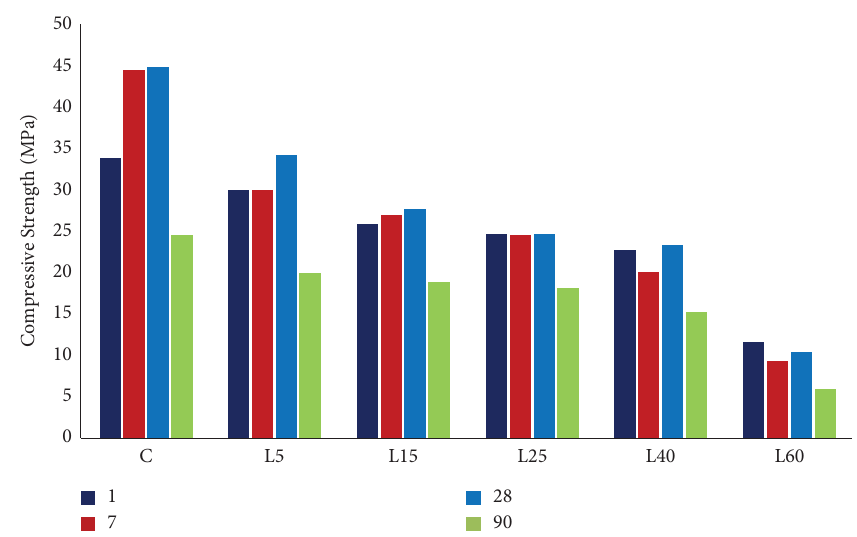
Figure 4: Compressive strength of the limestone mixtures at the age of 1 to